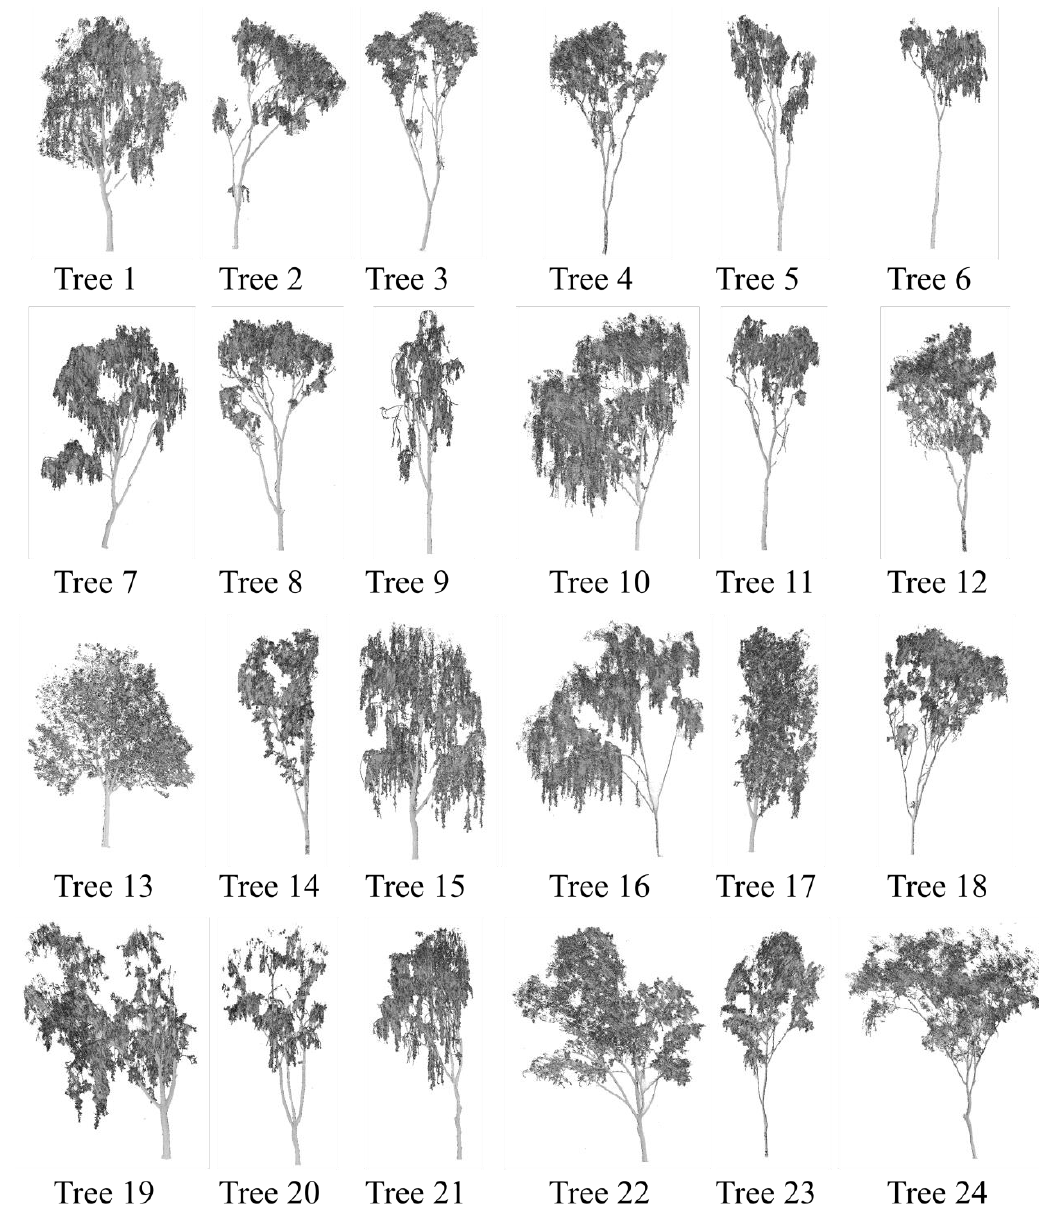
Figure 1. Extracted 24 tree point